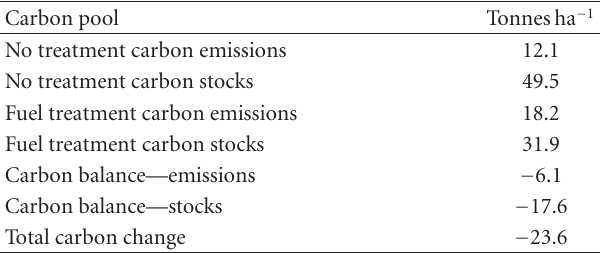
Table 4: Example carbon calculations from ArcFuels for analyzing carbon impacts of fuel treatments. The Forest Vegetation Simulator with the Fire and Fuels Extension is used to simulate a fuel treat- ment and wildfire, and the resulting carbon pools are compared to the same stand without a treatment. It is in this example that harvesting residue is burned on the site and thus contributes to emissions. The carbon balance determines whether the treatment could potentially contribute a carbon o ff set. Data are for stand 451 in the Mt. Emily study